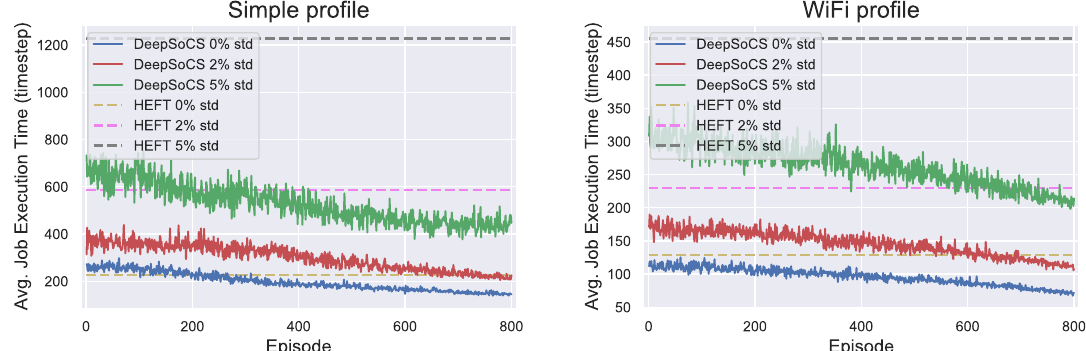
Figure 9. Figures show the average latency for DeepSoCSs and HEFTs with adding standard deviations. Left shows simple profile, and right shows WiFi profile. Note that the HEFT shows poor performances after adding variations. All tested with scale of 50.